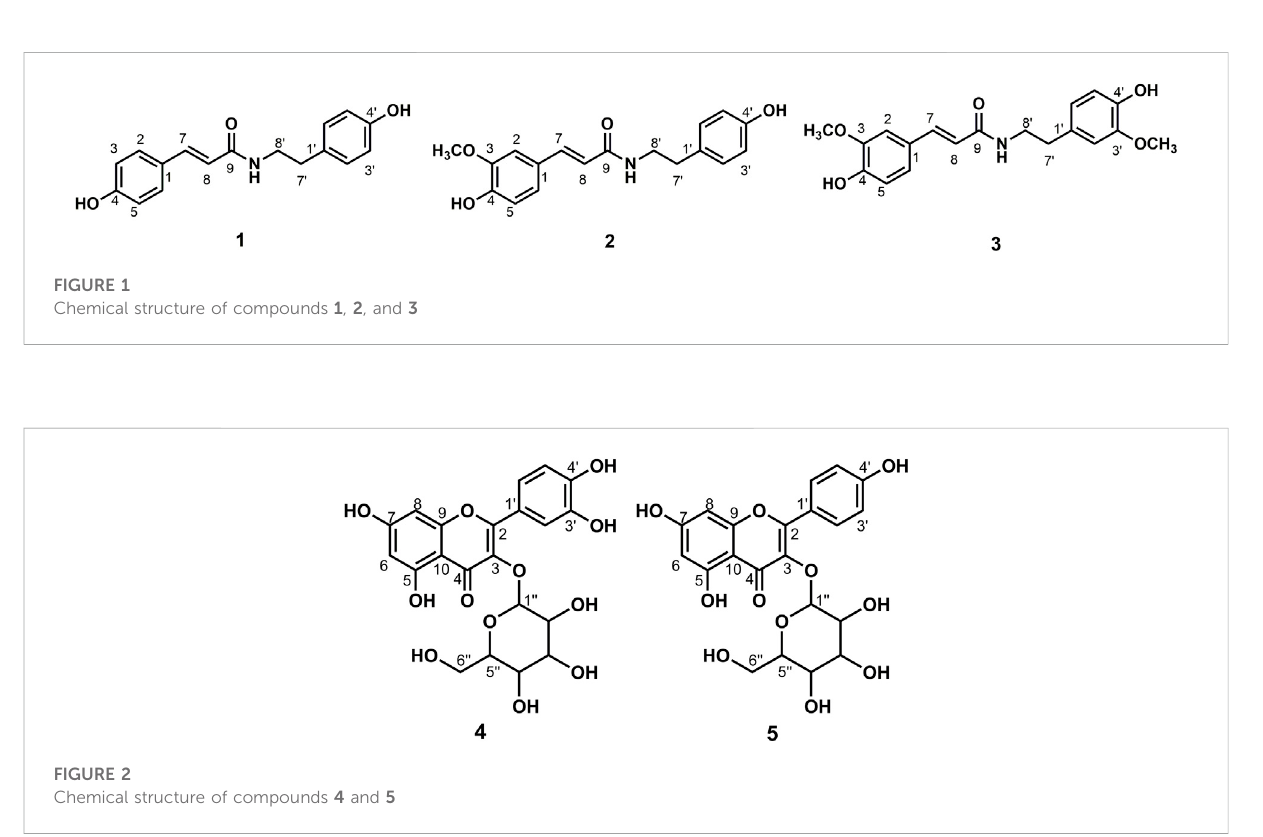
as N - trans -feruloyl tyramine and its molecular formula is shown in Figure 1. MS diagrams and 1 H-NMR and 13 C-NMR spectra were shown in Supplementary Figures S4 – S6, respectively.